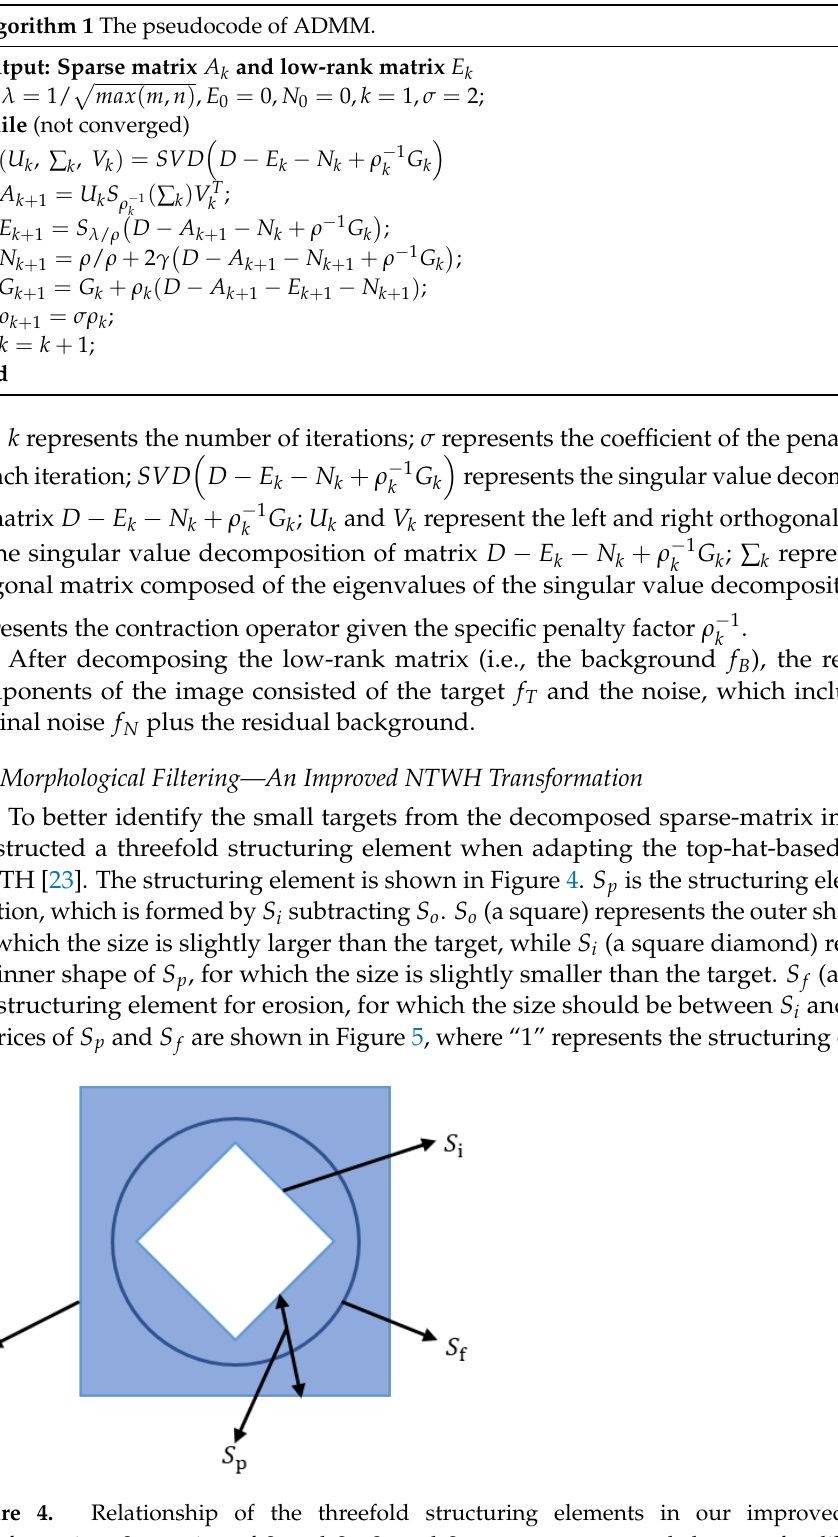
Figure 5. The matrix representations of the structuring elements. To demonstrate how this threefold structuring element works, the process of the im- proved NWTH transformation is shown in Figure 6, wherein the images of the target re- gion at each step are at the top and their corresponding matrices are at the bottom. The target is in the shape of 5 × 3, and its corresponding pixels are highlighted in blue in Figure 6a. With the specifically constructed structuring element 𝑆 𝑝 , the pixels in the surrounding area of the target all gained the local maximum values via dilation. Figure 6b shows the target was successfully highlighted by a rectangle (of bright pixels) while the target itself was restrained in a smaller diamond shape (of grey pixels). The result of erosion is shown in Figure 6c, wherein the target was enlarged into a rectangle (of grey pixels) with a high- lighted outer boundary (of bright pixels). This was because of the circle structuring ele- ment 𝑆 𝑓 had a size between the outer boundary and the inner boundary of 𝑆 𝑝 . The final result was obtained by subtracting Figure 6c from Figure 6a, wherein all background and noise were eliminated and the target was successfully obtained, as shown in Figure 6d. During the substruction, the pixels in the nontarget regions might result in negative val- ues, which should be set to 0. As a result, our improved NWTH transformation was de- fined as below: 𝑇𝑖𝑁𝑊 = 𝑓(𝑥, 𝑦) − 𝑚𝑖𝑛 ((𝑓(𝑥, 𝑦) ⊕ 𝑆 𝑝 ) ⊖ 𝑆 𝑓 ， 𝑓(𝑥, 𝑦))